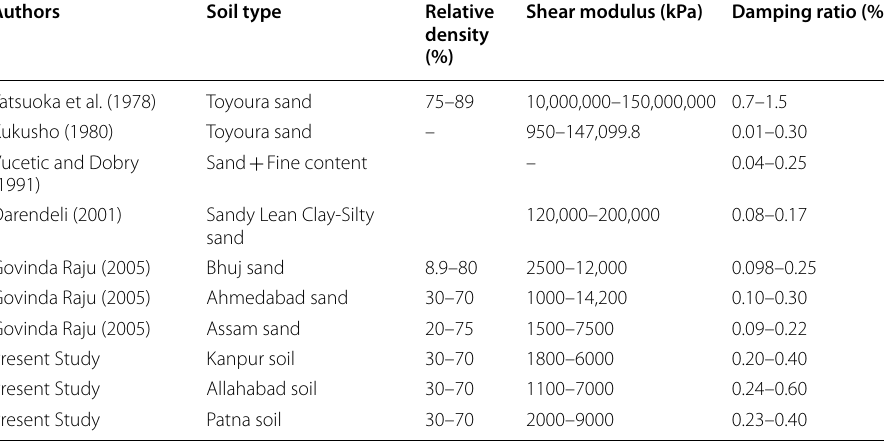
Table 6 Comparison of dynamic soil properties of present study with previous studies